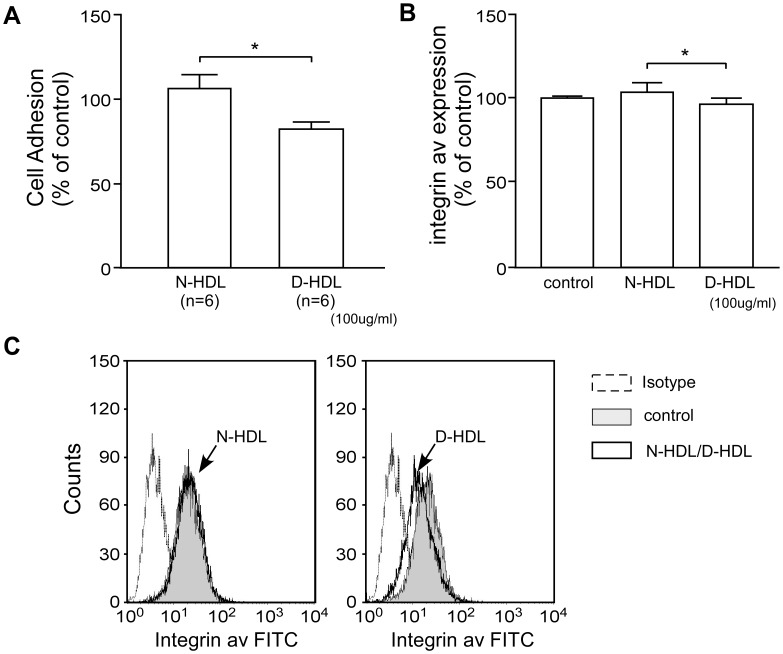
Diabetic HDL decreases cell adhesion to ECM. A)HUVECs were pretreated with N-HDL or D-HDL for 24 hours, and relative cell adhesion to ECM was determined after a 1 hour incubation, n = 6, mean ± SEM, *, p<0.05 by student’s t-test. B) HUVECs were pretreated with N-HDL or D-HDL for 6 hours. Integrin αv expression was determined by flow cytometry, n = 3, mean ± SEM, *, p<0.05 by student’s t-test. C) Flow cytometry overlay histogram shows integrin αv expression of HUVECs treated with N-HDL or D-HDL compared to control.